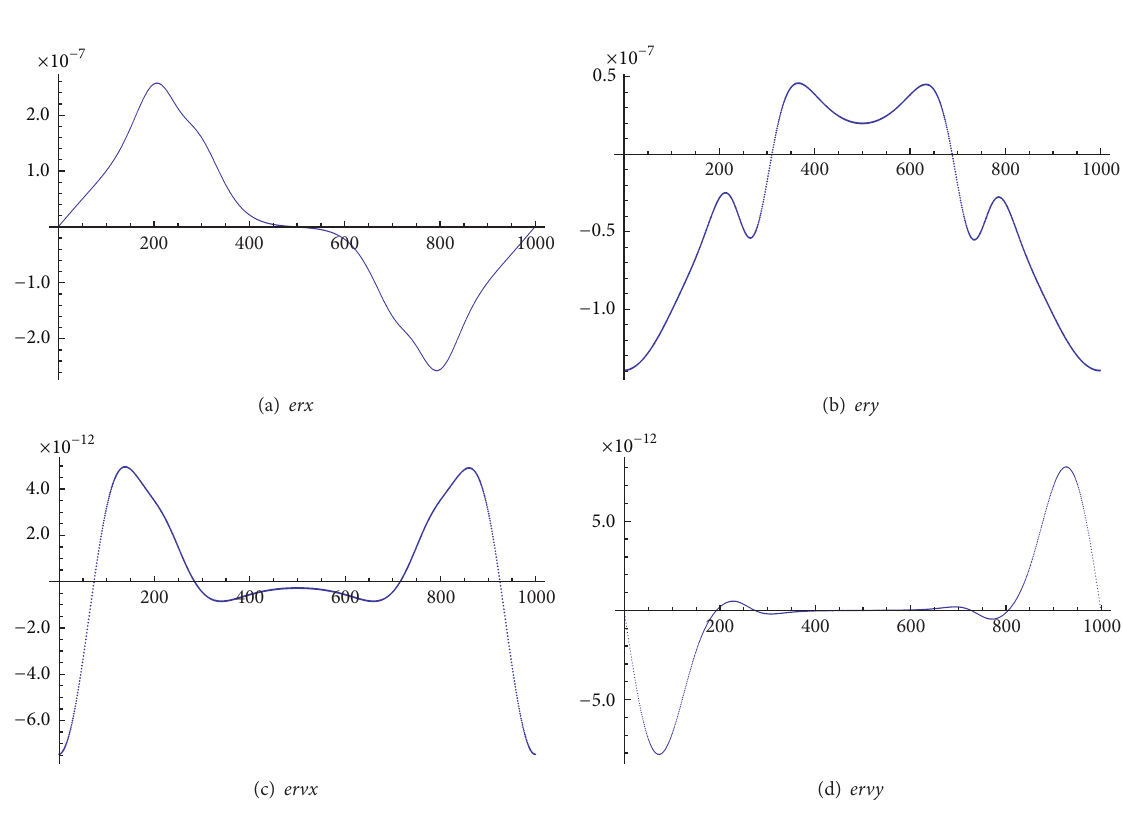
Figure 5: Local integration errors distribution 𝑒 = 0.7 , 𝛼 = 0.5